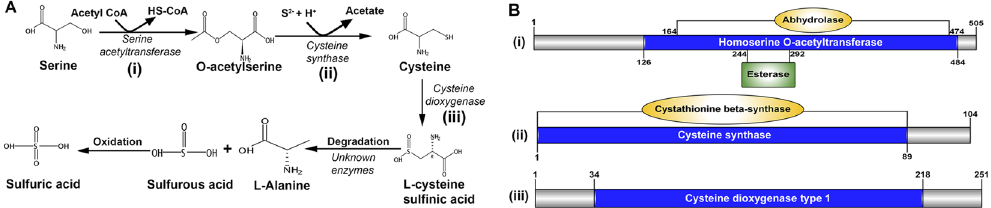
Figure 6. Identification of enzymes associated with the sulfuric acid biosynthesis pathway. ( A ) Pathway for biosynthesis of sulfuric acid. Those enzymes identified within the anterior lobe of the Charonia tritonis salivary gland are shown as (i), (ii) and (iii). ( B ) Schematics showing enzymes (i), (ii) and (iii) including characteristic domains. Biosynthetic enzymes derived from C. tritonis are listed in Supplementary Data